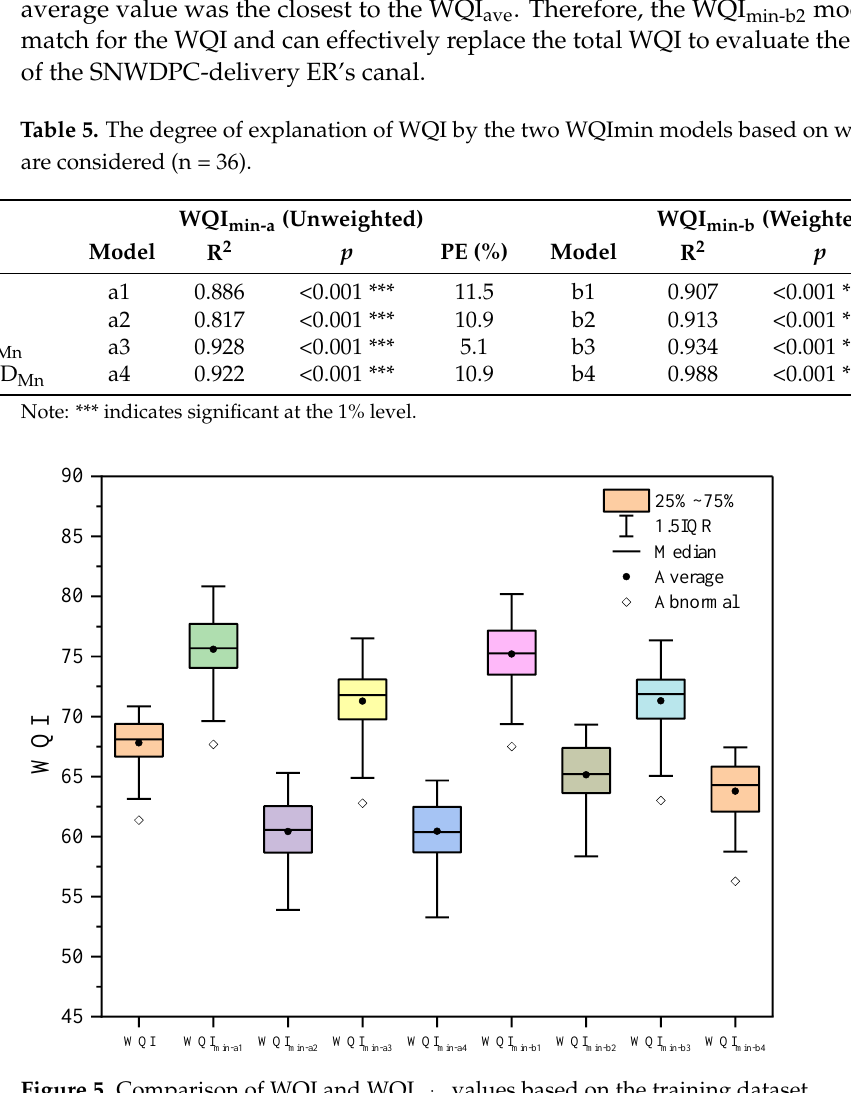
Figure 5. Comparison of WQI and WQI min values based on the training dataset.